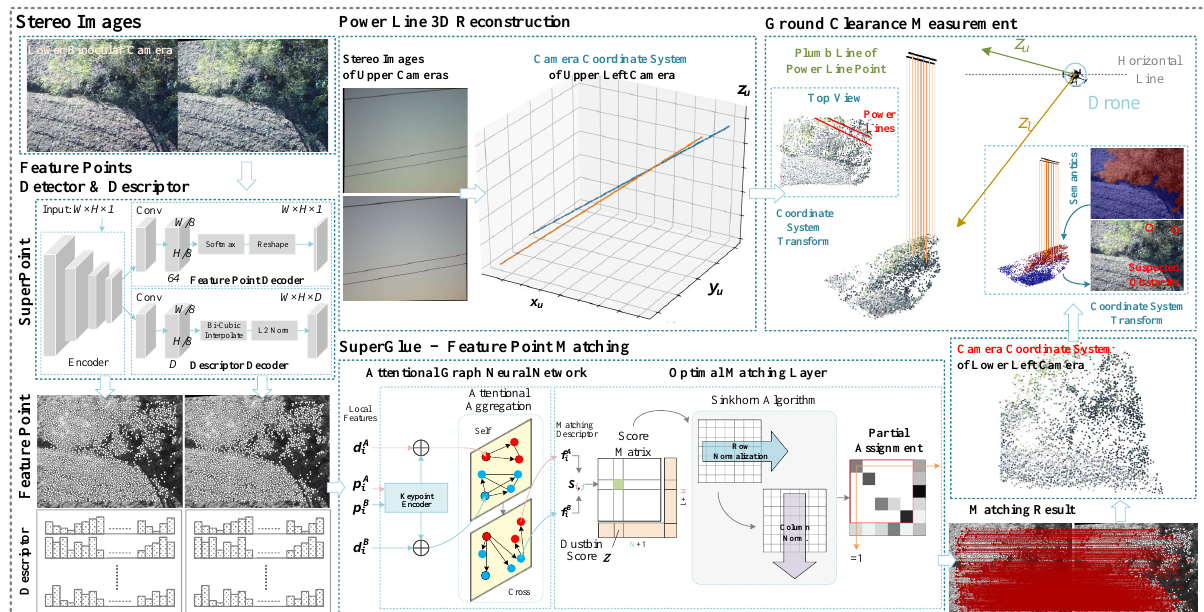
Figure 7. The process of the proposed clearance distance measurement and suspect obstacles detection